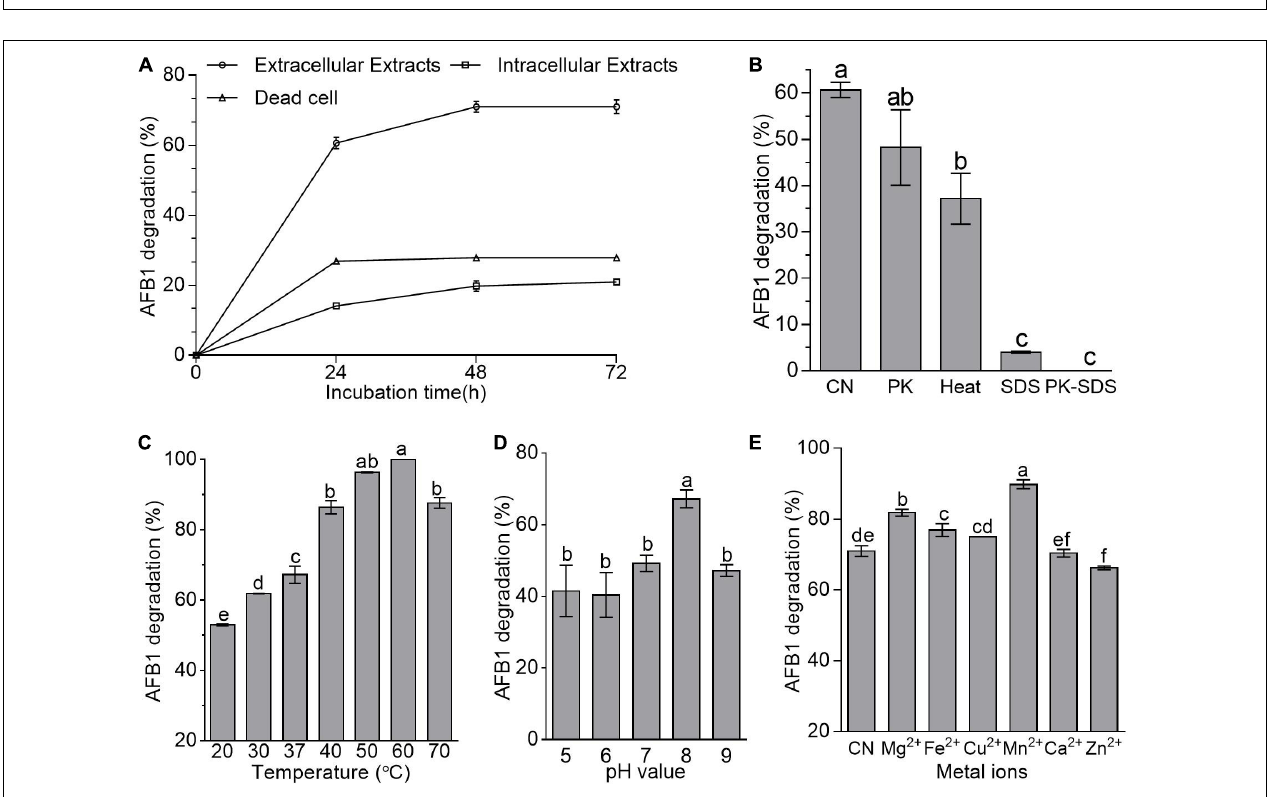
FIGURE 2 | AFB1 degradation among diverse cell components of B. amyloliquefaciens WF2020. (A) AFB1 degradation by extracellular extracts, intracellular extracts, and dead cells during 72-h incubation with 2 µ g/ml AFB1 at 37 ◦ C. (B) Effects of heat, proteinase K (PK), SDS, and proteinase K plus SDS on AFB1 degradation mediated by the cell-free supernatant after co-incubation for 24 h. (C–E) Effects of different temperatures (C) , pH values (D) , and metal ions (E) on AFB1 degradation mediated by the cell-free supernatant after co-incubation for 48 h. Different lowercase letters in the bars of each group indicate significant differences between treatments (Tukey’s test, p <